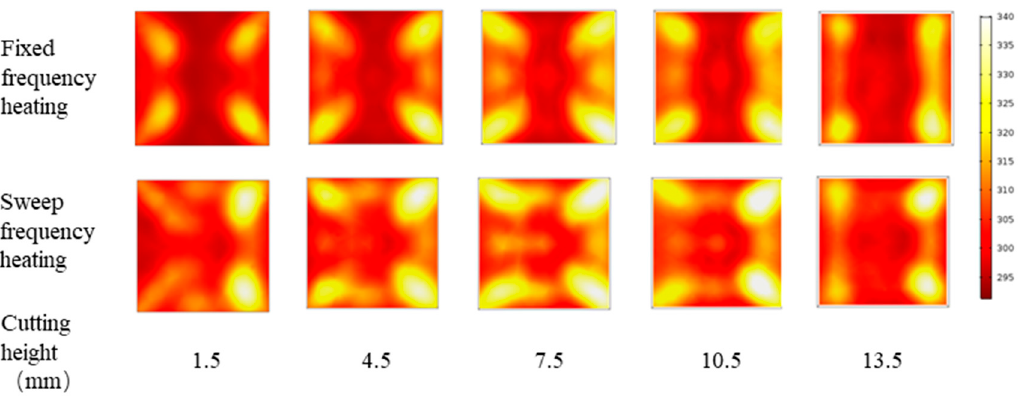
Figure 8. Simulation results of different profile temperature distributions between frequency sweep and fixed frequency heating (unit: K). Table 2. Sweep frequency and fixed frequency heating simulation results.